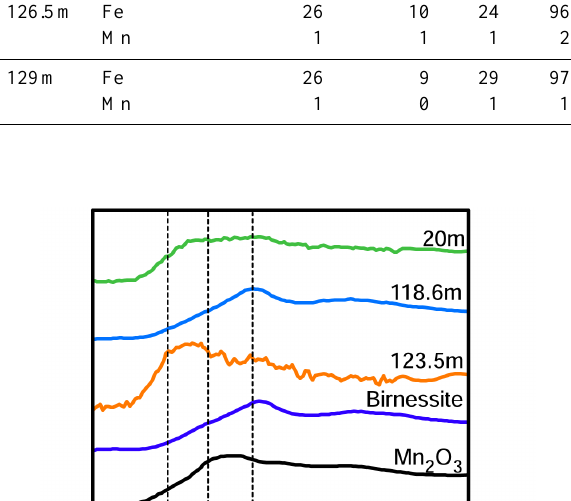
Fig. 5. Averaged XAS spectra from 118.6m water column particles, XAS spectrum of synthesized birnessite, and the residual spectrum from subtracting these two